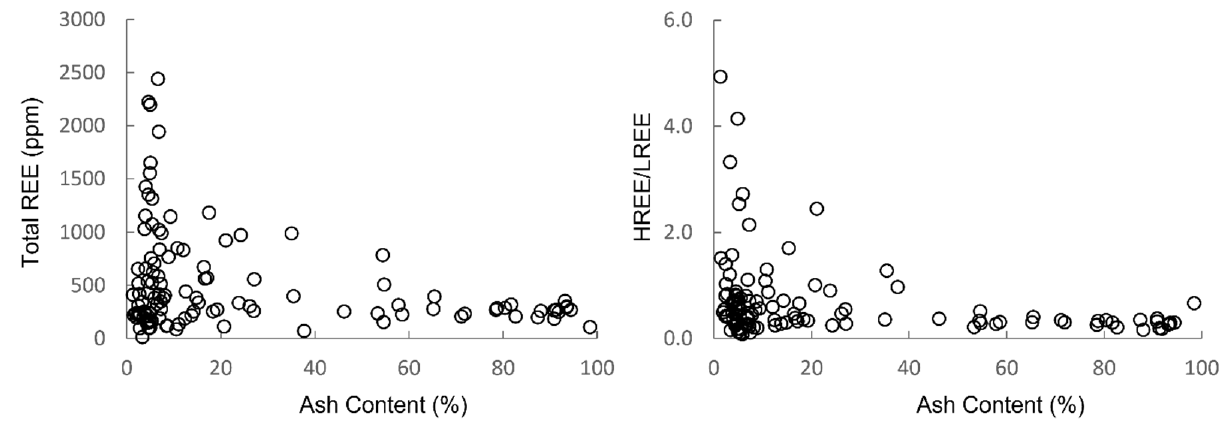
Figure 3. Crossplots( left )totalREEinppmonashbasisand( right Figure 3. Cross plots ( left ) total REE in ppm on ash basis and ( right ) HREE/LREE ratios versus ash content.